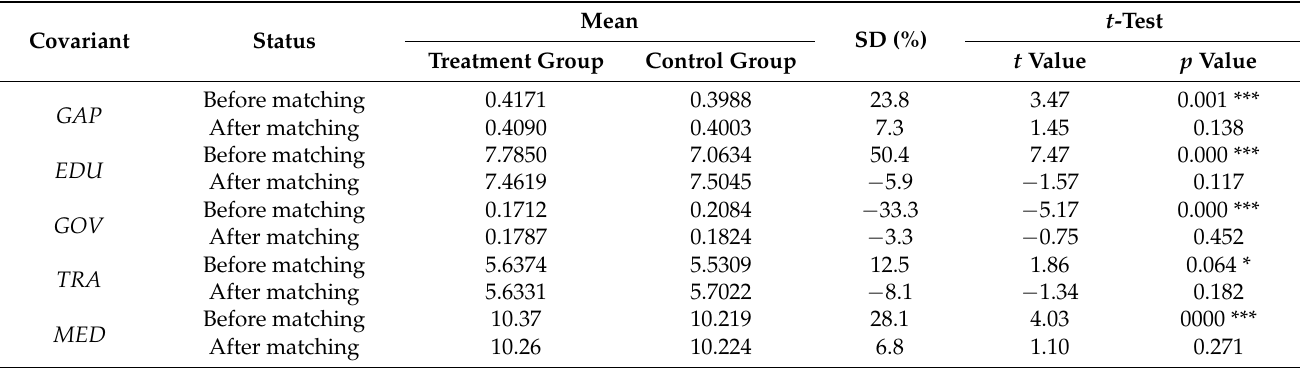
Table 2. Balance test of covariant.